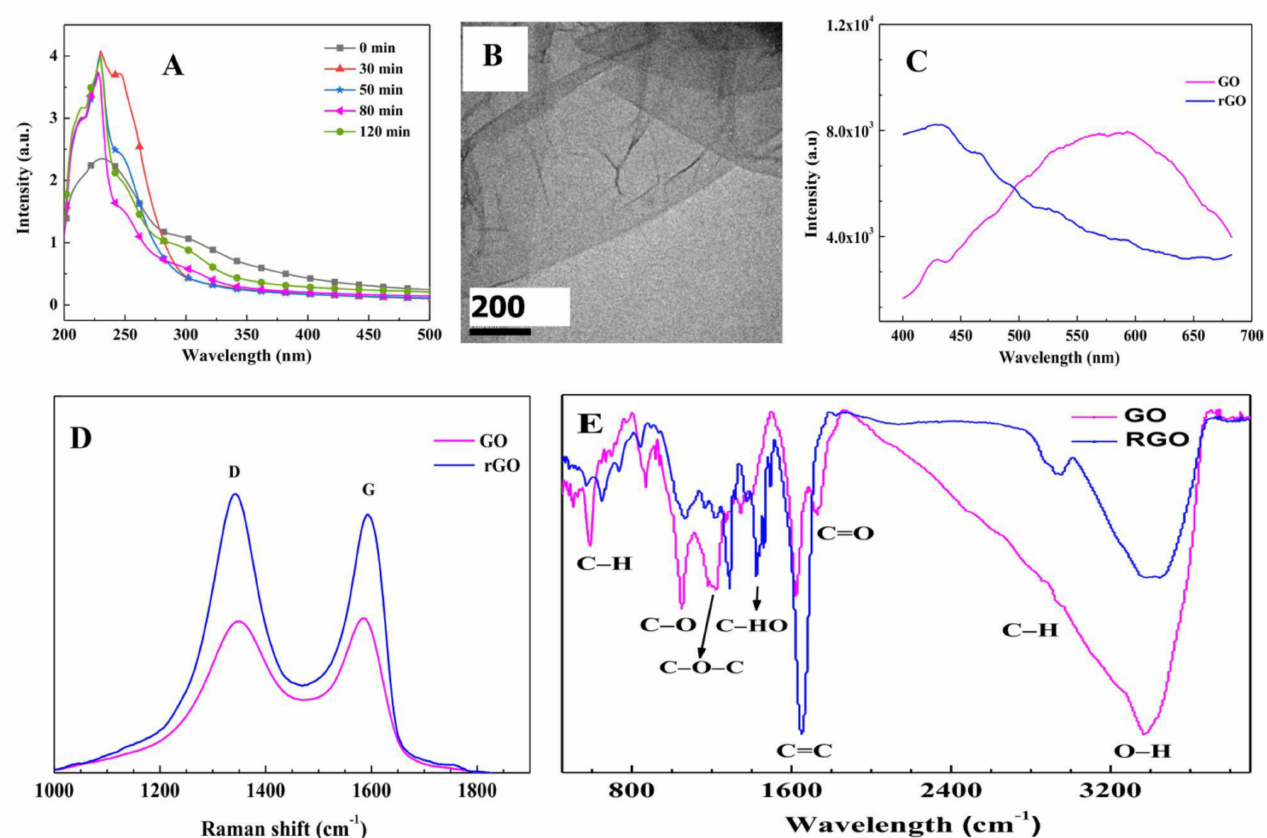
Figure 1. Characterization of graphene oxide (GO) and reduced graphene oxide (rGO). ( A ) UV-Vis absorption spectra at different reduction times when GO was reduced to rGO; ( B ) TEM image of rGO; ( C ) photoluminescent (PL), ( D ) Raman, and ( E ) FTIR spectra of GO and